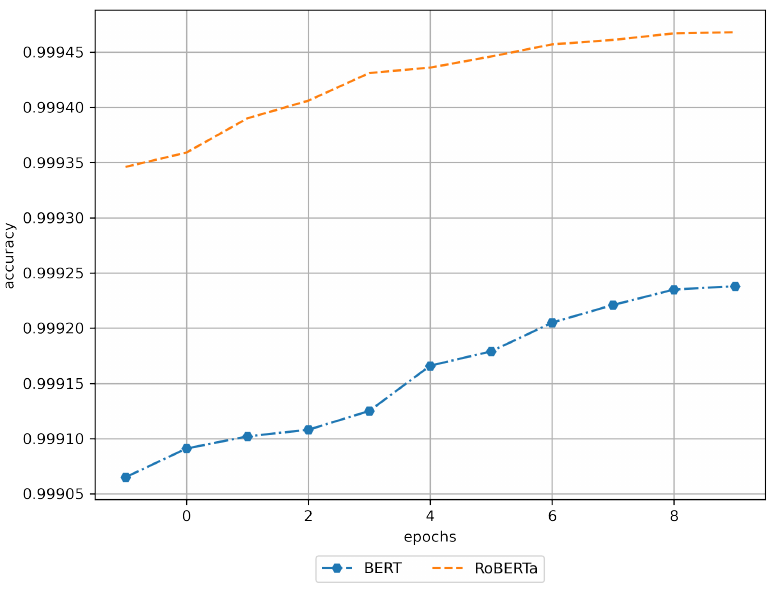
Figure 1. Evolution of the accuracy of neural networks devoted to source code generation during the training epochs.